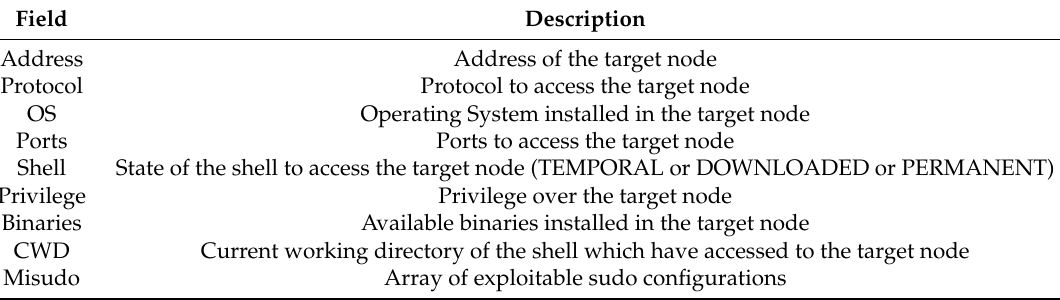
Table 1. Model of red team agent’s